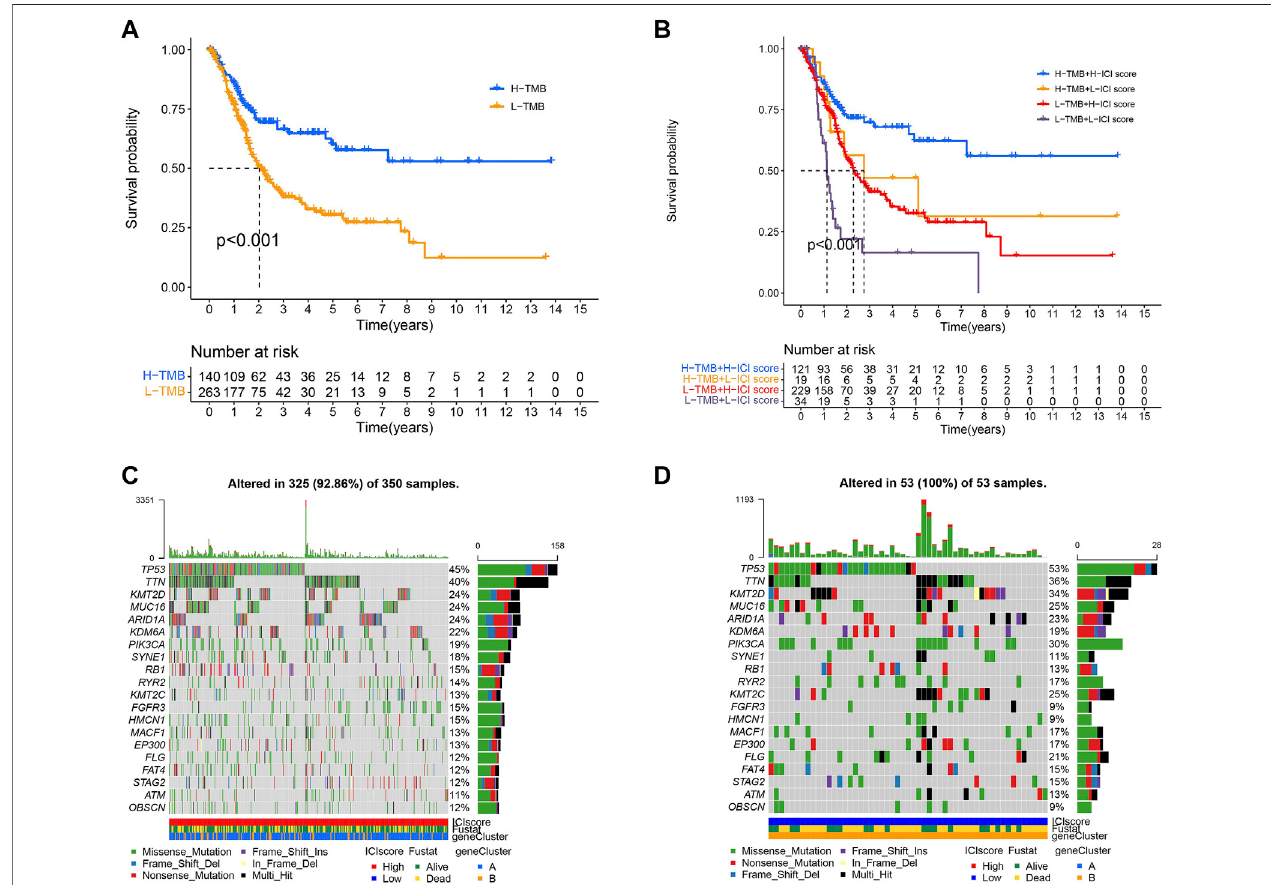
FIGURE 7 | TMB and ICI scores were used to evaluate the prognosis of TOGA-BOLA cohort patients. (A) Survival time of patients in high- and low-TMB groups (log-ranktest, p < 0.0010. (B) Thehigh-TMBgroupcombinedwiththehighICIscoregroupshowedthebestprognosisinBLCApatients(log-ranktest, p < 0.001; (C,D) The distribution of driver genes in high and low ICI score groups: high ICI score group (C) and low ICI score group (D) .